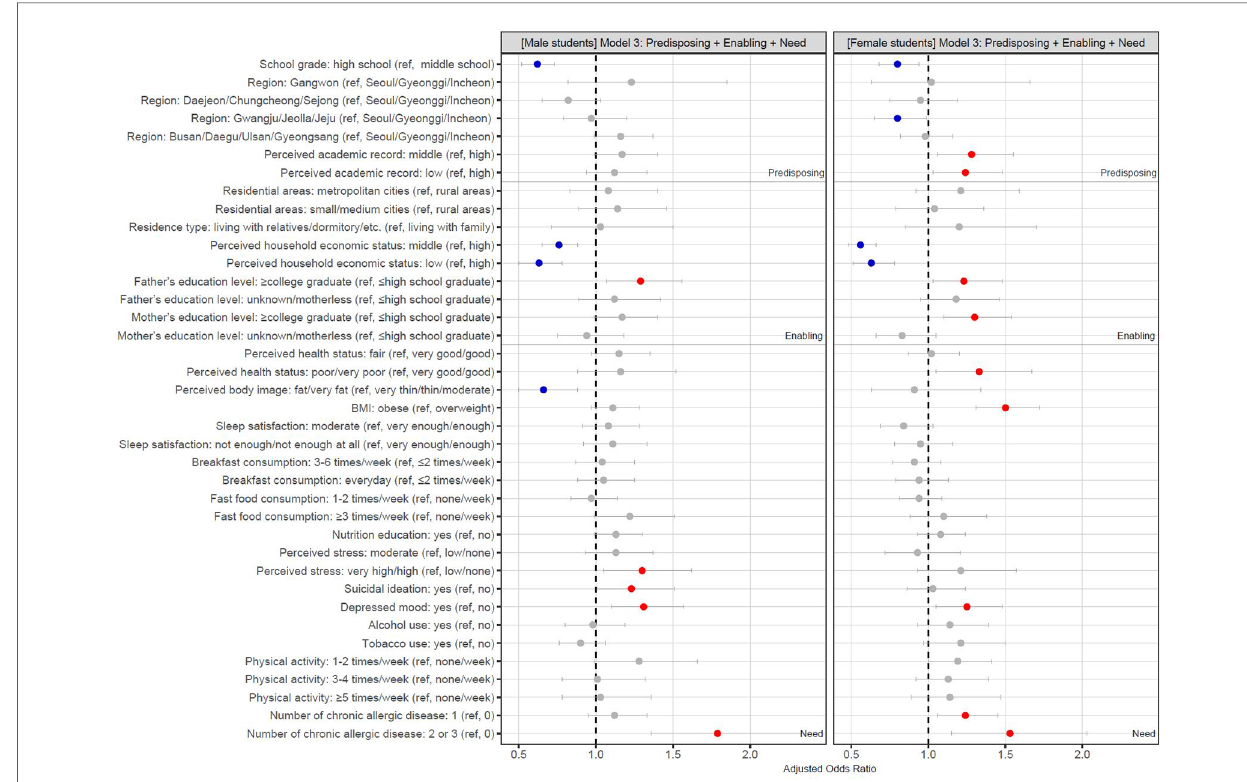
FIGURE 2 Adjusted odds ratios and 95% con fi dence interval in fully adjusted model 3. HM, herbal medicine; ref, reference group. The adjusted odds ratios and 95% con fi dence intervals of fully adjusted model 3 are visually presented to show the association between HM use for weight loss and the combined variables of predisposing, enabling, and need factors. Red dot indicates that the group is more likely to use HM than the reference group. Blue dot indicates that the group is less likely to use HM than the reference group. Grey dot indicates that the group is not signi fi cantly related to the reference